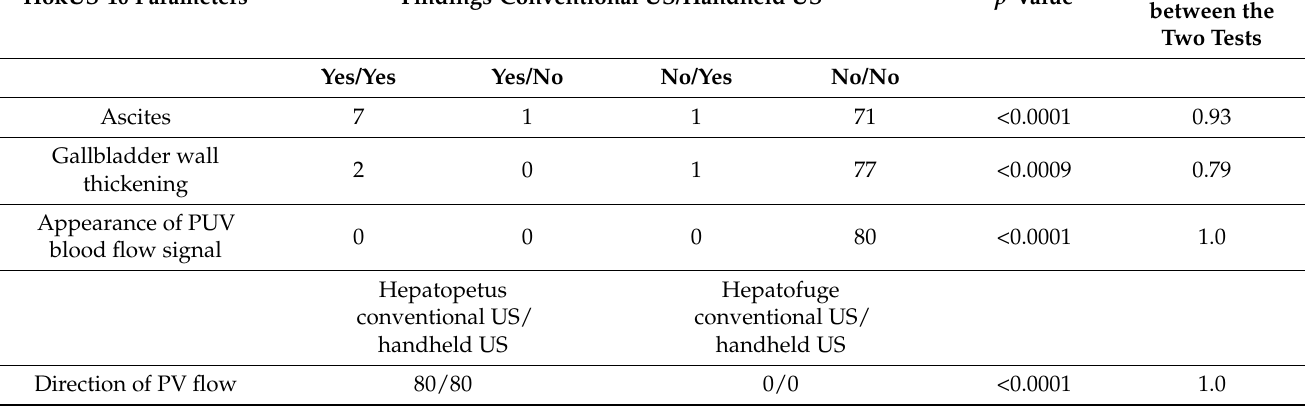
Table 3. Results obtained by conventional and handheld ultrasound on assessment of ascites, gallbladder wall thickening, and para-umbilical veins.